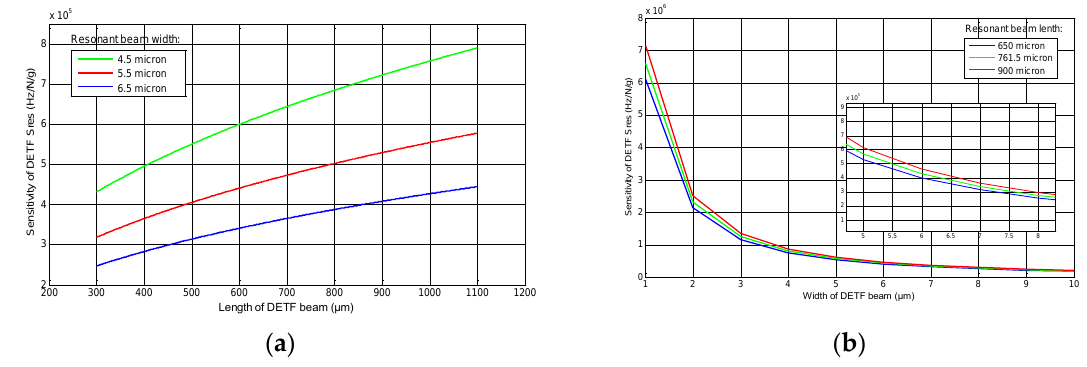
Figure 6. ( a ) S res as a function of the DETF beam length for a series of beam widths; and ( b ) S res as a function of the DETF beam width for a series of beam lengths.